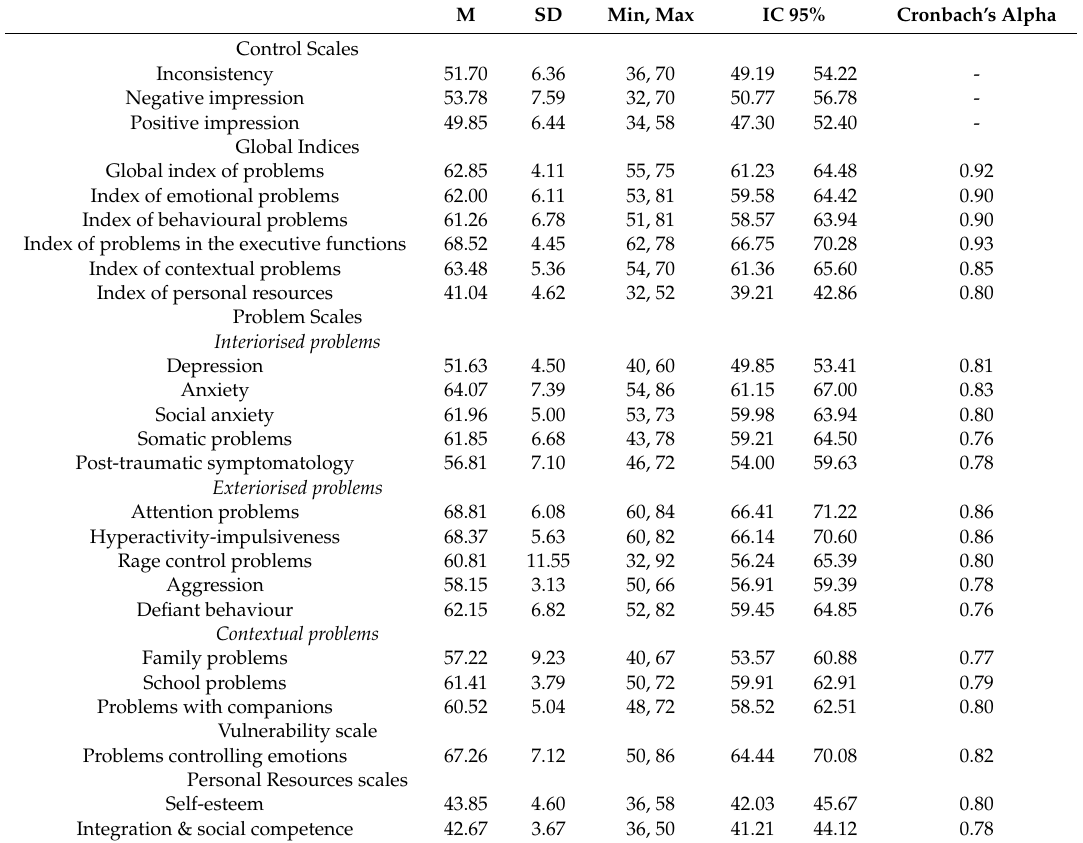
Table 2. Means and standard deviations of the system of evaluation for children and adolescents